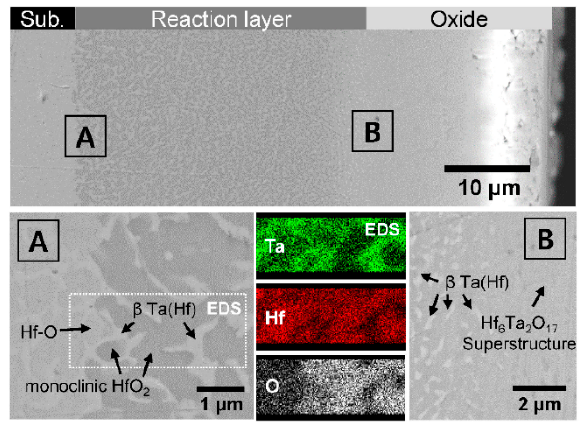
Figure 3. SEM and EDS results on the reaction layer of the HT-3 sample after oxidation.